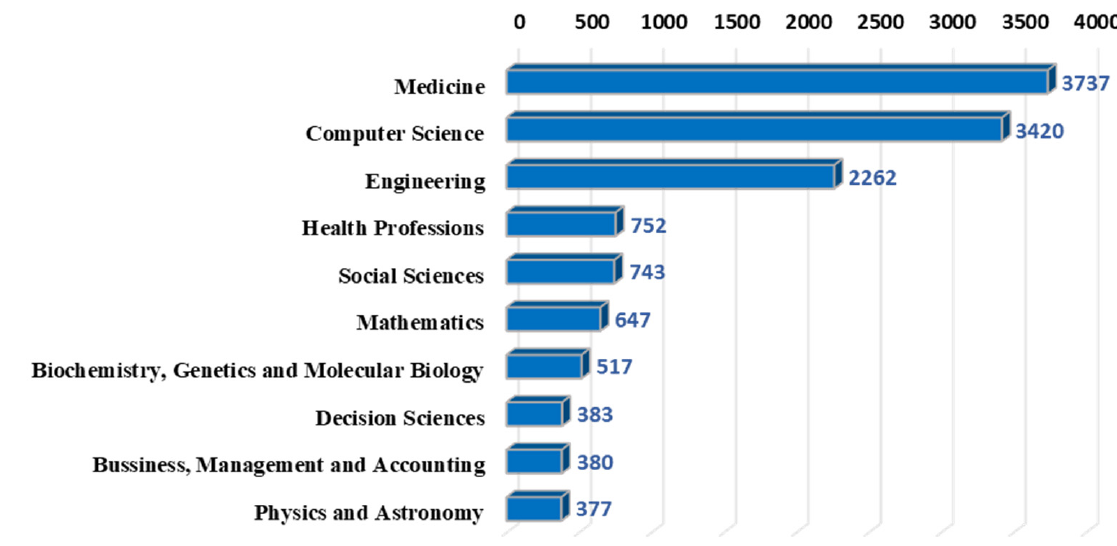
Figure 3. Top 10 subject categories in healthcare.